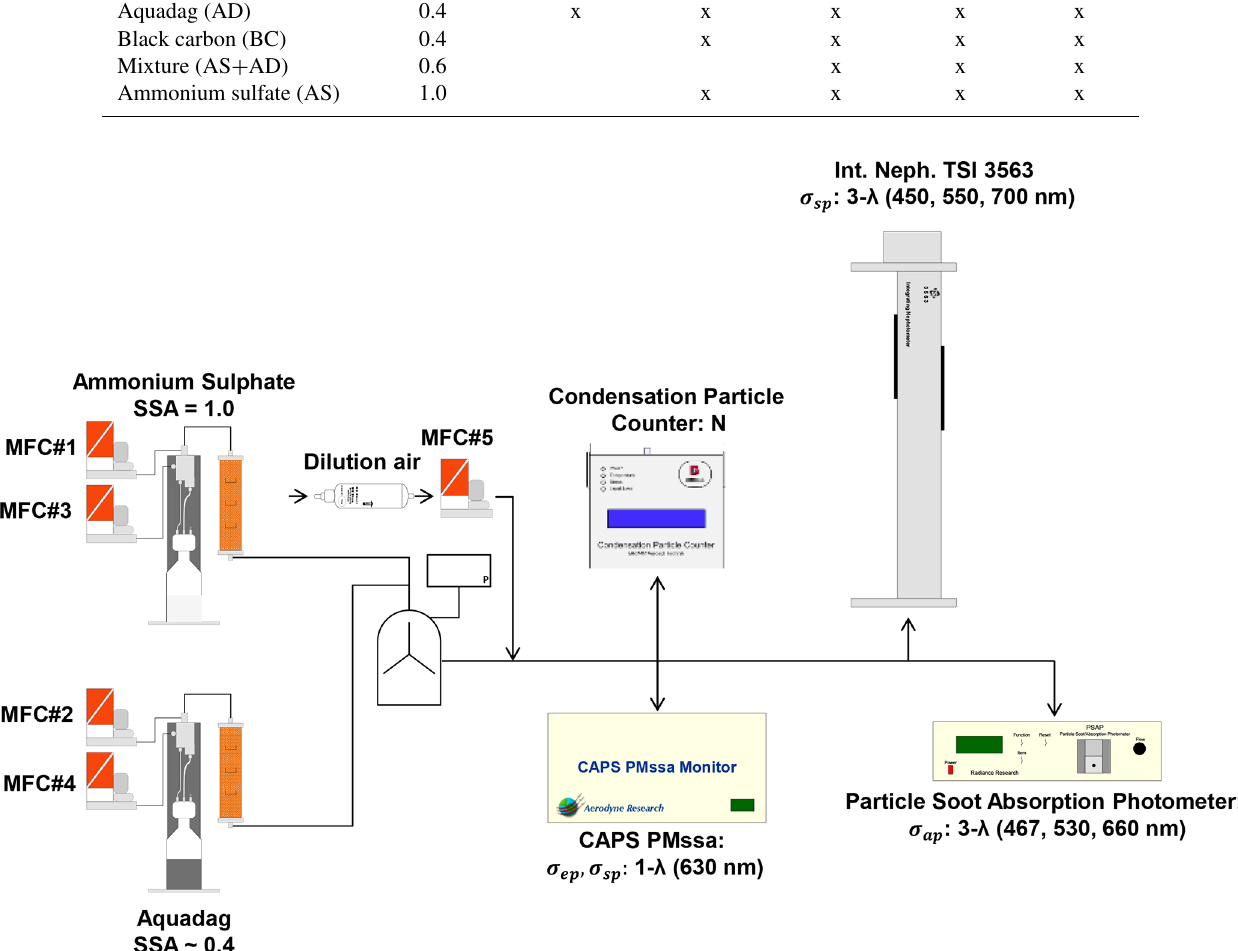
Figure 1. Instrumental setup applied in the optical-closure study.